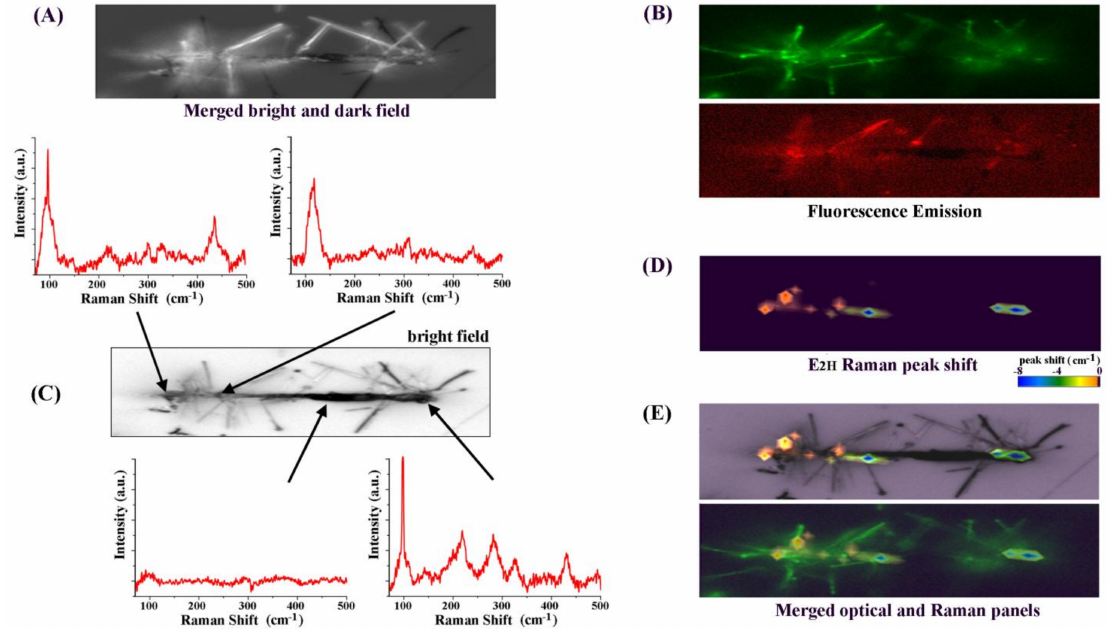
Figure 5. Representative panels displaying spatially correlated data between optical, fluorescence emission, and Raman scattering profiles measured from individual NBs with Cu-doped ZnO NRs. ( A , B ) The optical panel in ( A ) displays a superimposed, bright- and dark-field image of Cu-doped ZnO NRs on a Cu 3 Si NB. The corresponding fluorescence emission profiles along the NB are shown in panel ( B ) where the top and bottom frames display the emission collected at wavelength ranges of 510–540 nm and 575–640 nm, respectively; ( C ) Exemplar Raman spectra spatially resolved along the length of the NRs/NB module are presented; ( D ) The E 2H peak shift, characteristic of Cu-doped ZnO NRs grown on a Cu 3 Si NB, is mapped along the NB via NB position-resolved Raman spectroscopy; ( E ) The top and bottom panels are the merged view of bright-field and E 2H Raman peak shift (top) and that of fluorescence and E 2H Raman peak shift (bottom). All bright-field, fluorescence, and mapped Raman images shown are 4.5 µ m by 20 µ m in